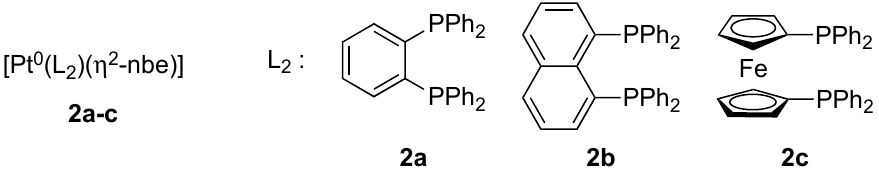
Figure 1. Bidentate phosphanes used as ligands in platinum complexes 2a – c . L 2 = 1,2-bis(diphenylphosphino)benzene (dppbe), 1,8-bis(diphenylphosphino)naphthalene (dppn), 1,1’-bis(diphenylphosphino)ferrocene (dppf); nbe =